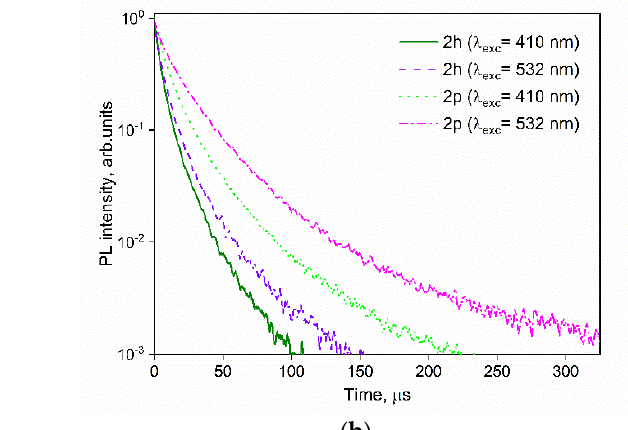
Table 3. Luminescence decay times for solid complexes at room temperature.